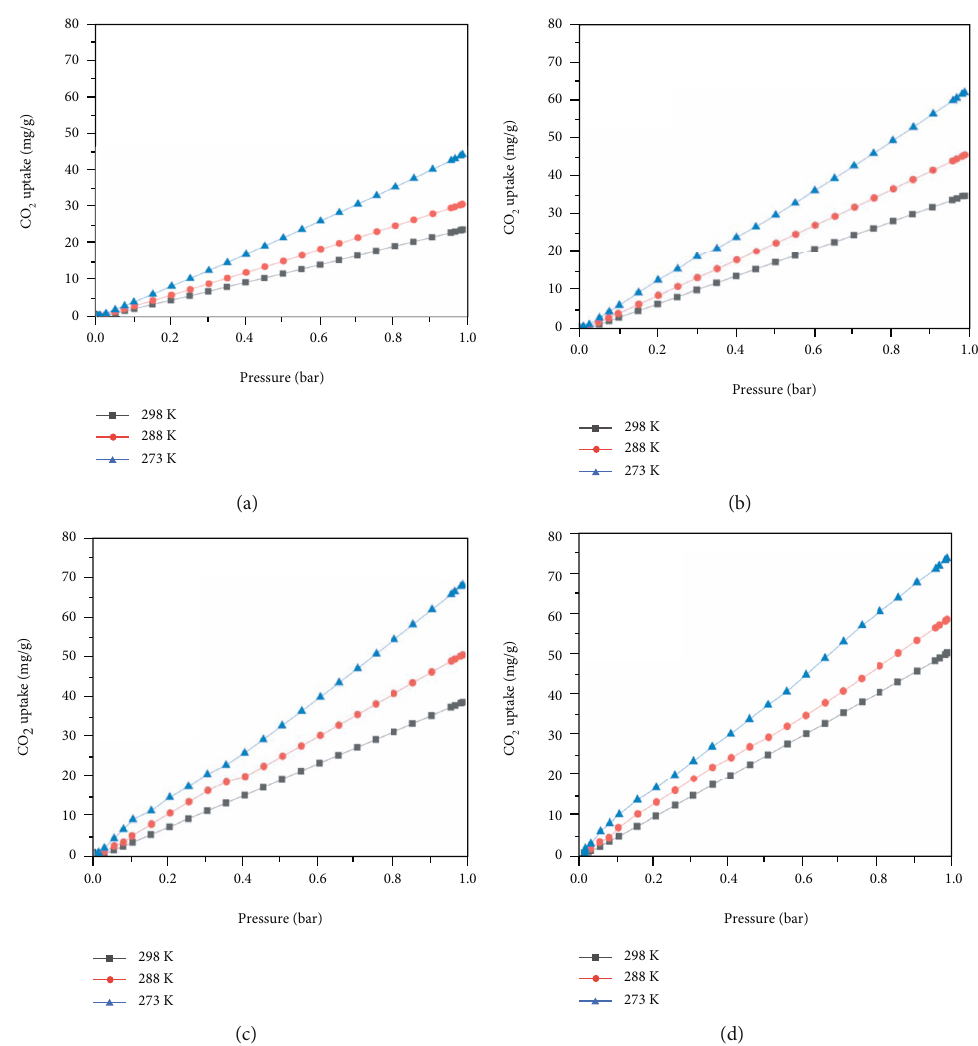
Figure 5: The CO adsorption isotherms on the amine@ZIF-8 materials at 273K, 288K, and 298K. (a) ZIF-8; (b) MA-ZIF-8; (c) ED-ZIF-8; 2 (d)